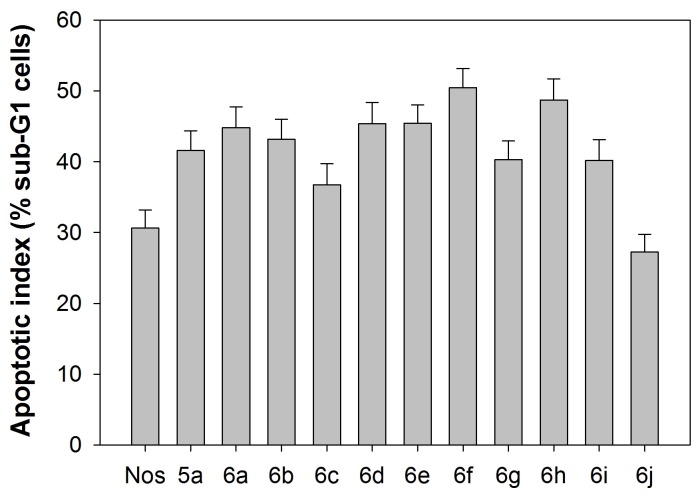
Graphical representation of the quantitation of apoptotic index (percent sub-G1 cells) at 25 µM at 72 hours for all the compounds.Results are representative of three experiments performed in triplicate. The variation in apoptotic index among the third generation α-Noscapine derivatives is statistically significant (F = 18.30, P < 0.001) based on 1-way ANOVA test.